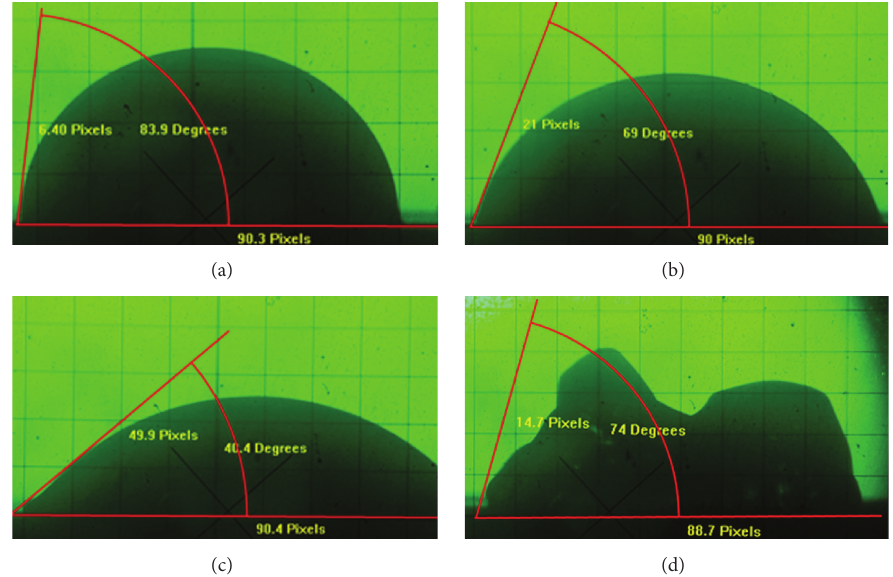
Figure 5: The contact angle of (a) CTS and (b) Lact-CTS-1, (c) Lact-CTS-2, and (d) Lact-CTS-3 measured by the static sessile drop method.